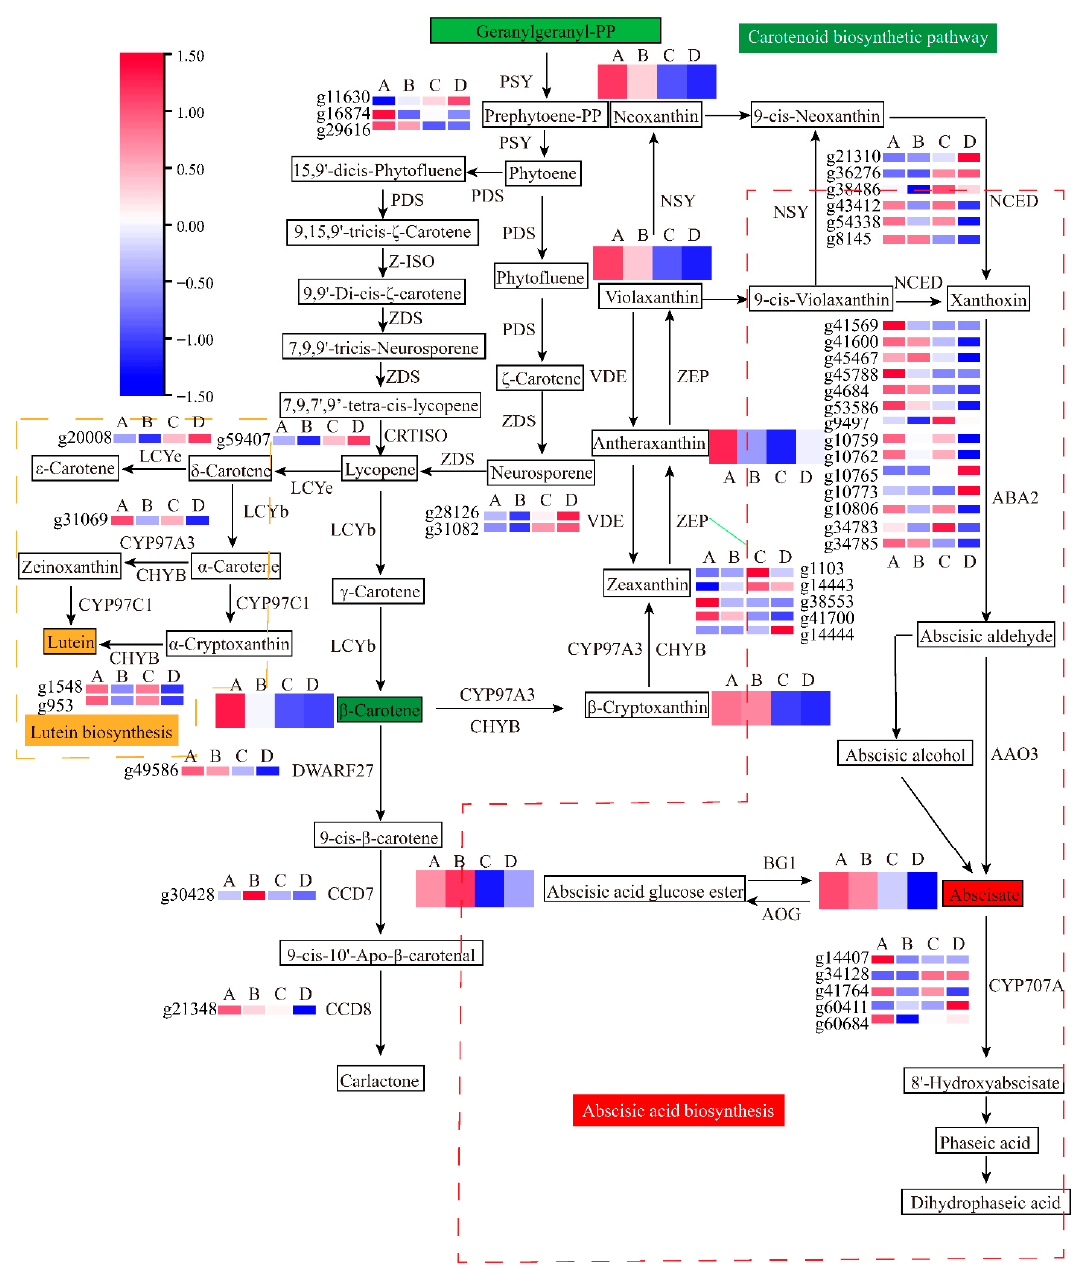
Figure 5. The carotenoid and ABA metabolic pathways exhibiting DEG and DAM enrichment. (A: BS-S2; B: BS-S4; C: S19-S2; D: S19-S4.). PSY ( g29616 ) expression in BS has been shown to be significantly upregulated rela- tive to levels in S19 storage roots at the S2 and S4 stages. CHYB expression in the storage roots of these sweet potato types trended downward from the S2 to the S4 stage, with CHYB gene ( g1548 and g953 ) expression levels in BS storage roots that were 3.56-, 3.85-,